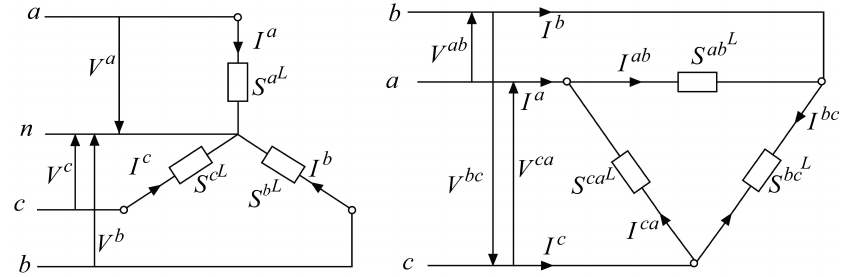
Figure 1. Wye and delta connections for three-phase loads [68].